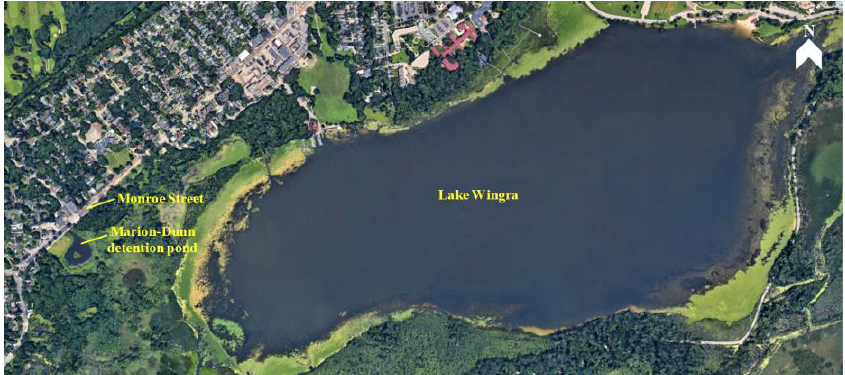
Figure 4. Marion Dunn wet detention pond located in Madison, Wisconsin.